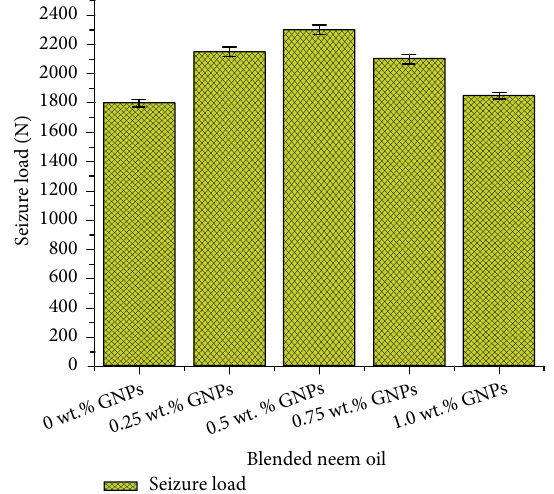
Figure 9: Seizure load of various wt.% of GNPs-neem nano-